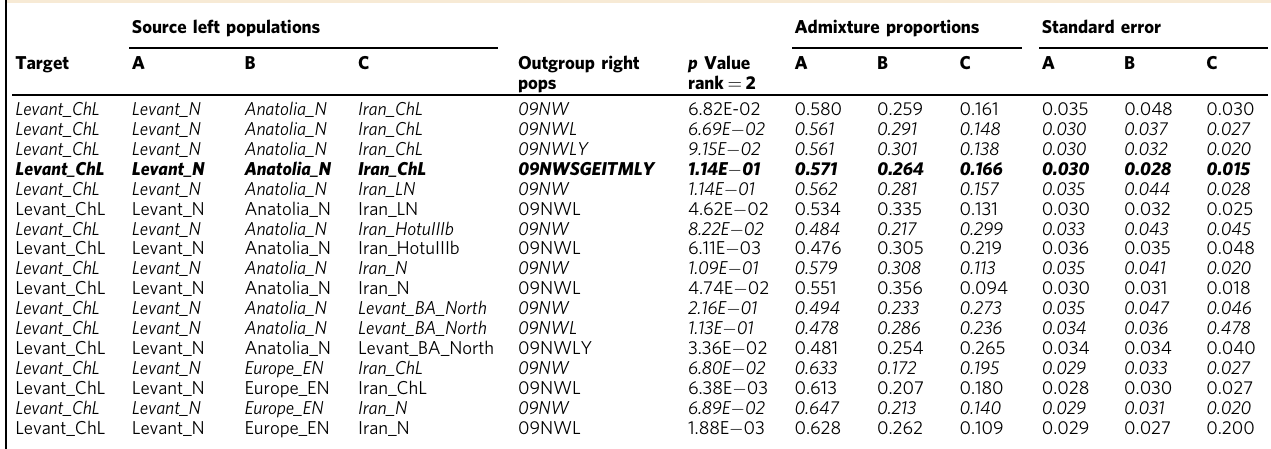
Table 1 Plausible models of Levant_ChL as a mixture of three sources Source left